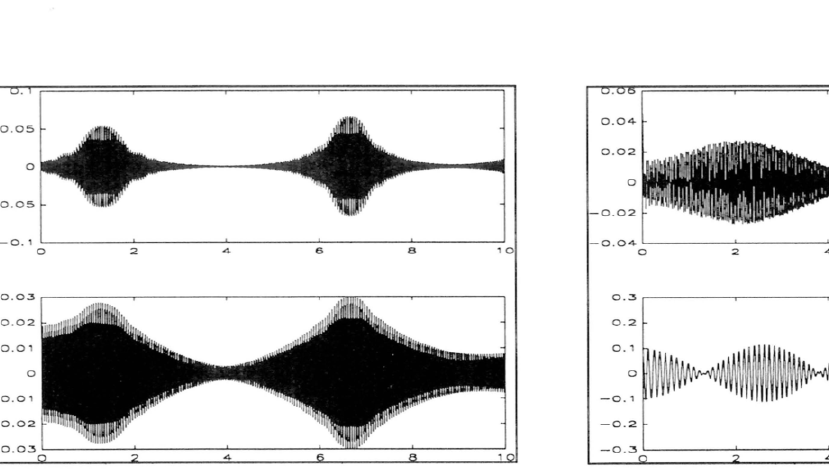
FIGURE 9 Harmonic run-through of constant filters with weighting 1/60 and 1/150.